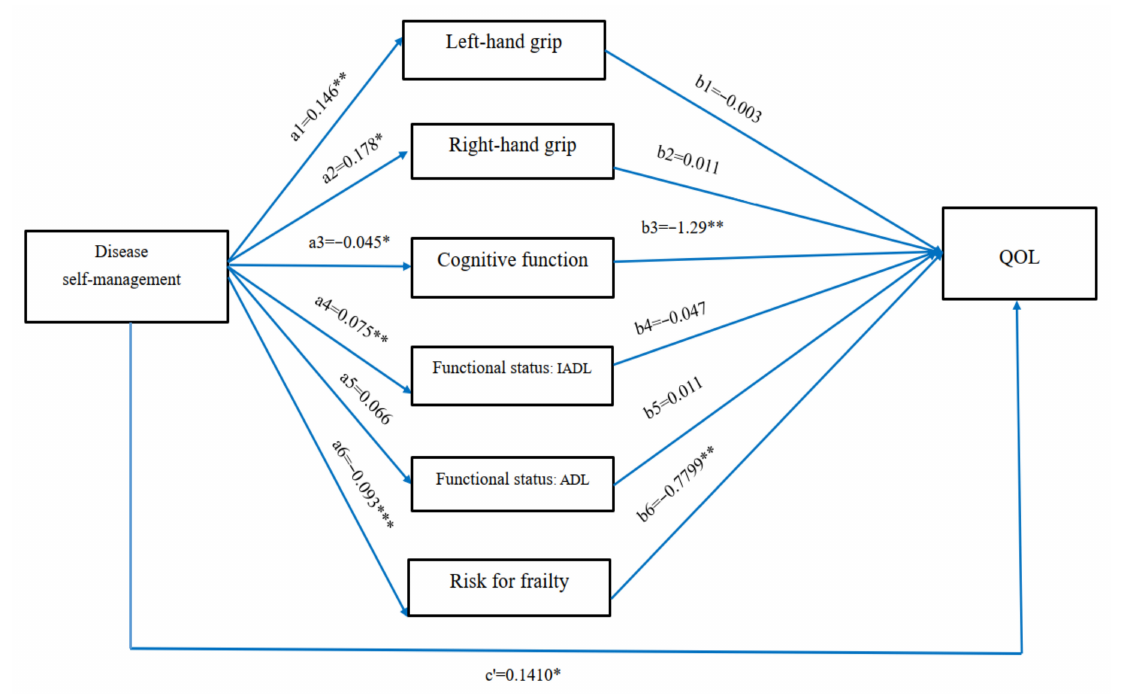
Figure 1. Model of the mediating roles played by maintaining health among older adults with chronic illness. Model showing the mediating role of maintaining health status and the relationship between disease self-management and quality of life. a = Direct effect of independent variable (disease self- management) on mediator (maintaining health status). b = Direct effect of mediator (maintaining health status) on outcome variable (quality of life). c’ = Direct effect of independent variable (disease self-management) on outcome variable (quality of life). * p < 0.05, ** p < 0.01, *** p <